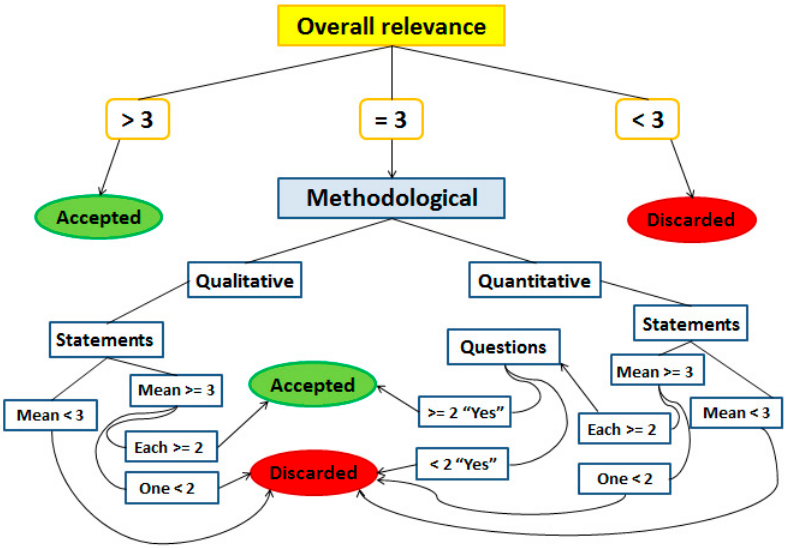
Figure 1. Graphic of the acceptance process of the papers.